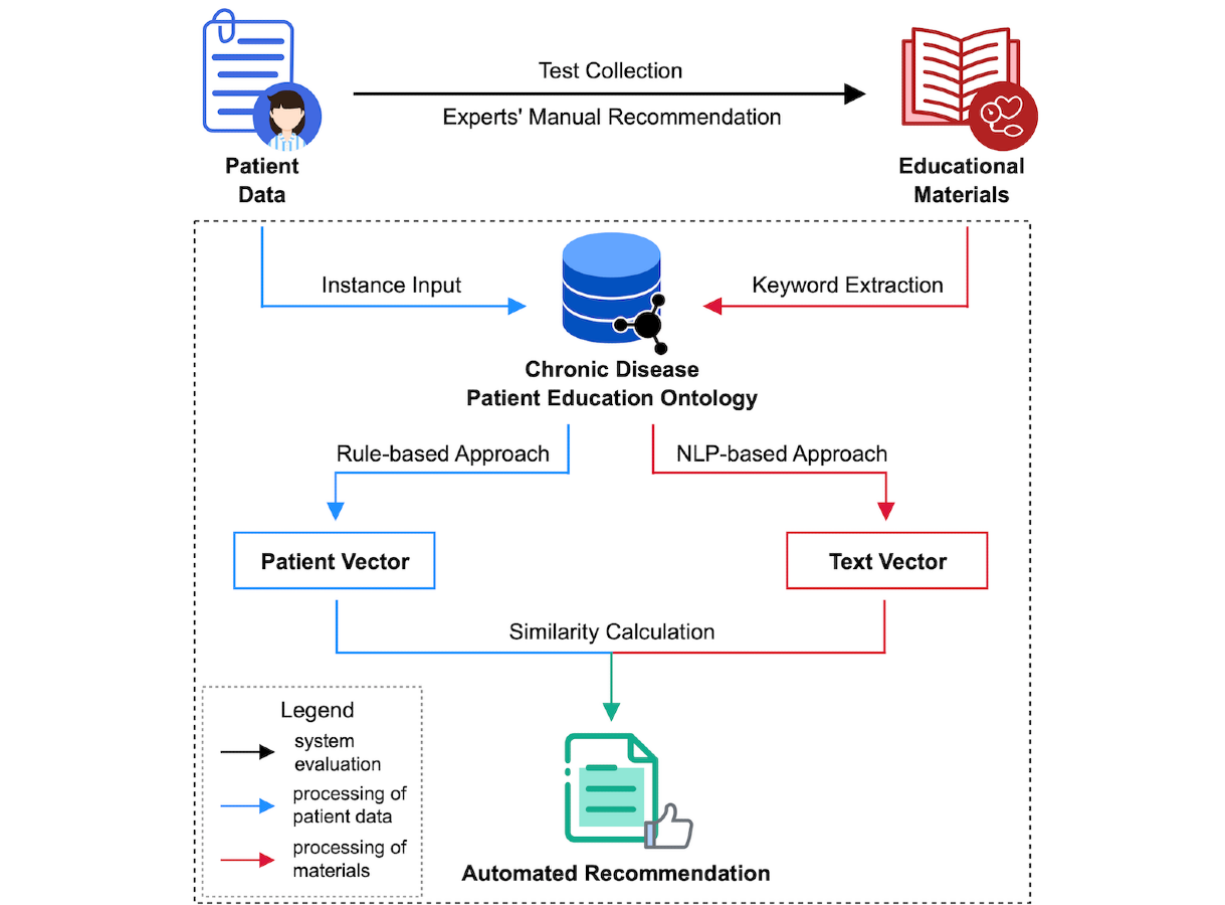
Figure 1. Overall study